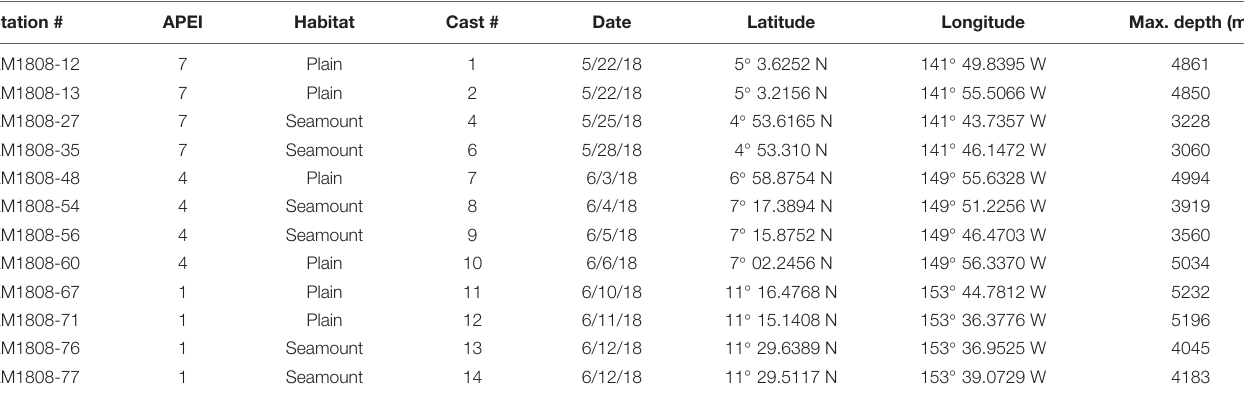
TABLE 2 | List of conductivity, temperature and depth (CTD) casts from which seawater was collected for eDNA. Station